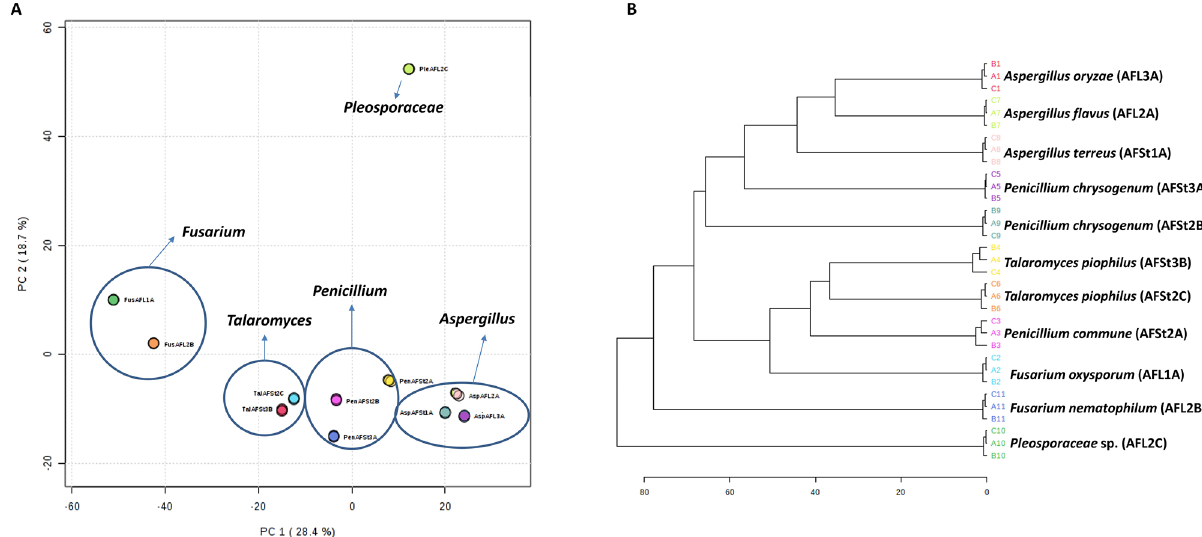
Figure 3. Score plots representing PCA ( A ) based on the HRMS data obtained for the endophytes extracts, and their chemotaxonomic clustering dendrogram ( B ). The plots were generated by MetaboAnalyst 4.0 28 (https ://